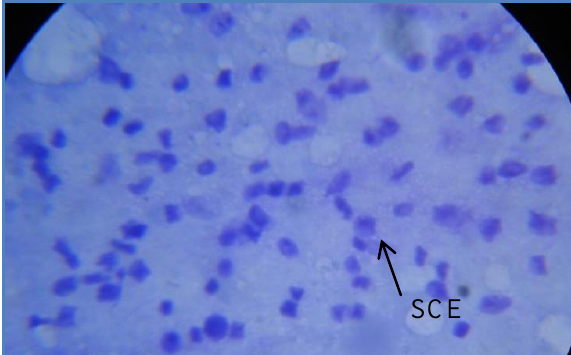
Figure, 4: Sister chromatid exchange in chick embryo cells after 10 µg levofloxacin in-ovo inoculation after 7 days of incubation (Hoechest stain 100x under light microscope)